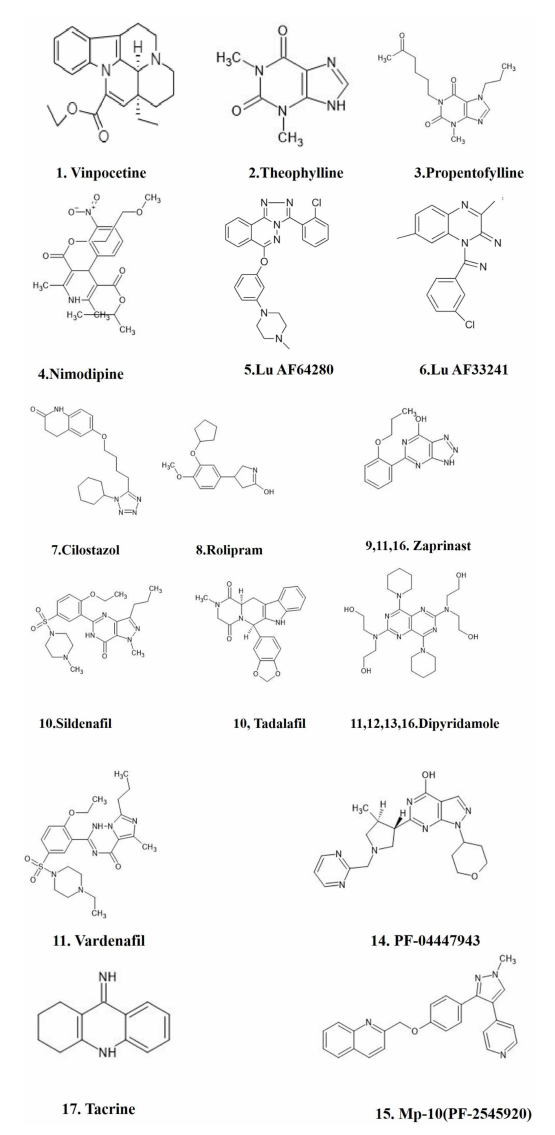
FIGURE4 FDA approved PDE inhibitors for the treatment of AD. The figure is original and generated by Bio-render software.